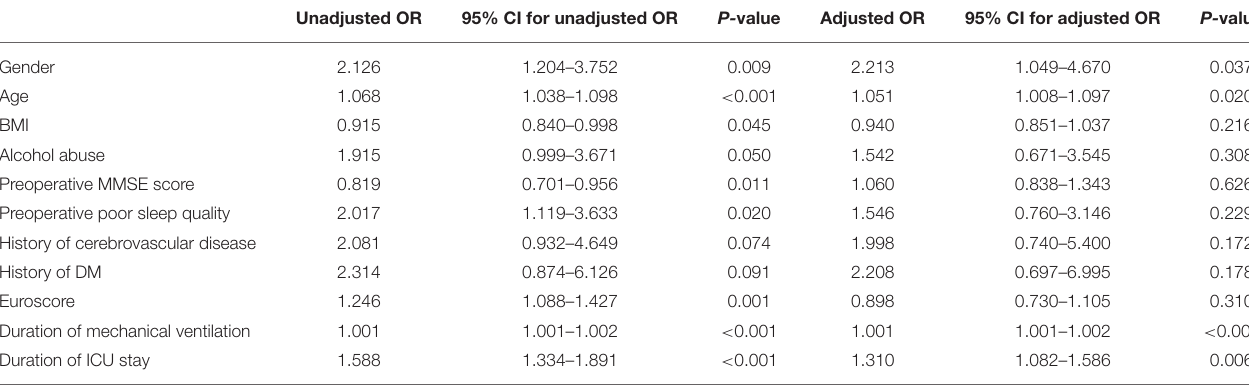
TABLE 2 | The logistic regression analysis of screened variables.